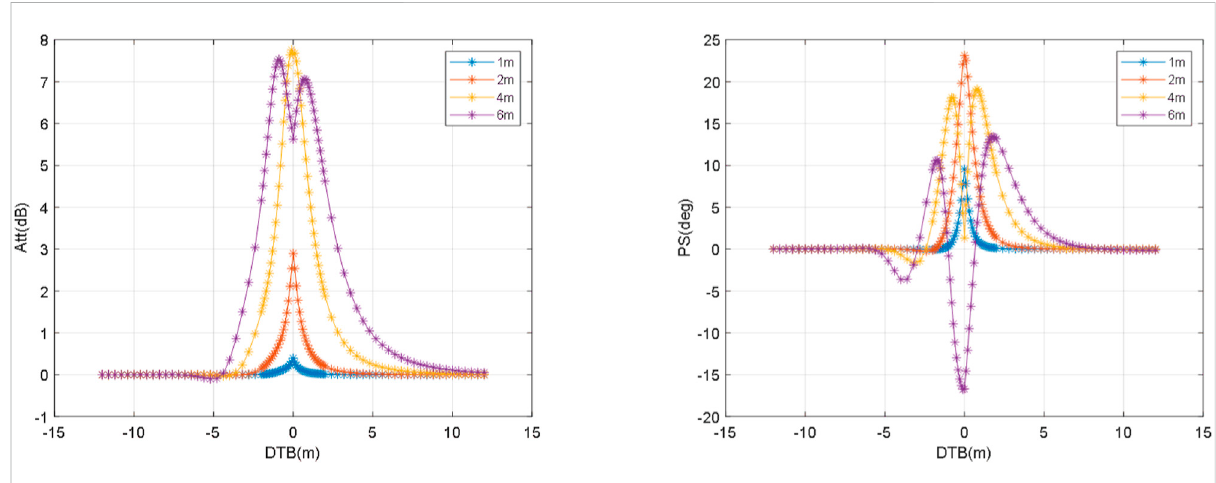
FIGURE 12 Response of the tilted receiver at different source distances.